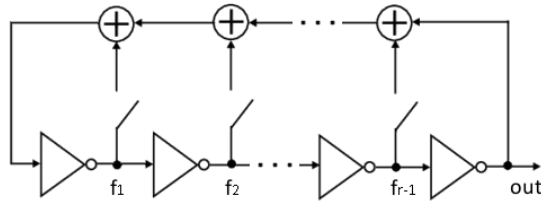
Figure 1. Fibonacci ring